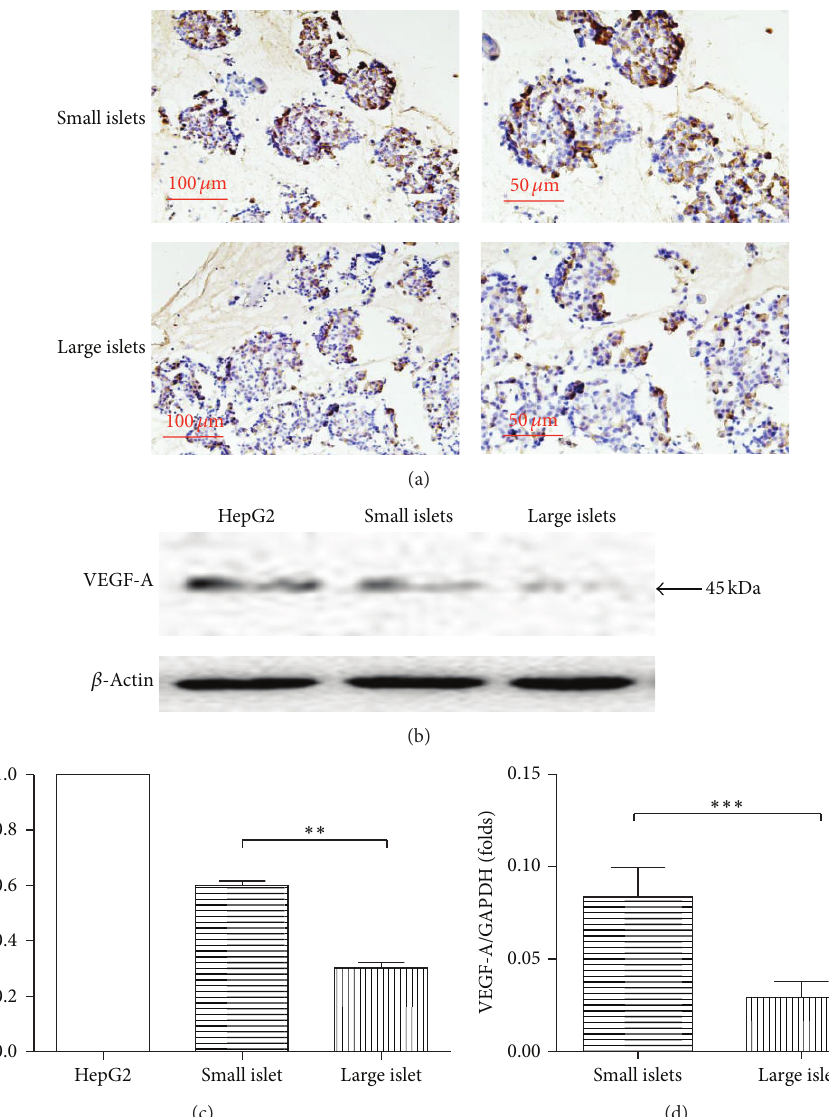
Figure 6: Small islets expressed more abundant VEGF-A. Small islets are apparently enriched in intrinsical VEGF-A expression verified by immunostaining of VEGF-A (brown) in situ and western blot (b and c, 𝑃 = 0.0010 ) as well as qRT-PCR (d) ( 𝑃 = 0.0002 ) of isolated